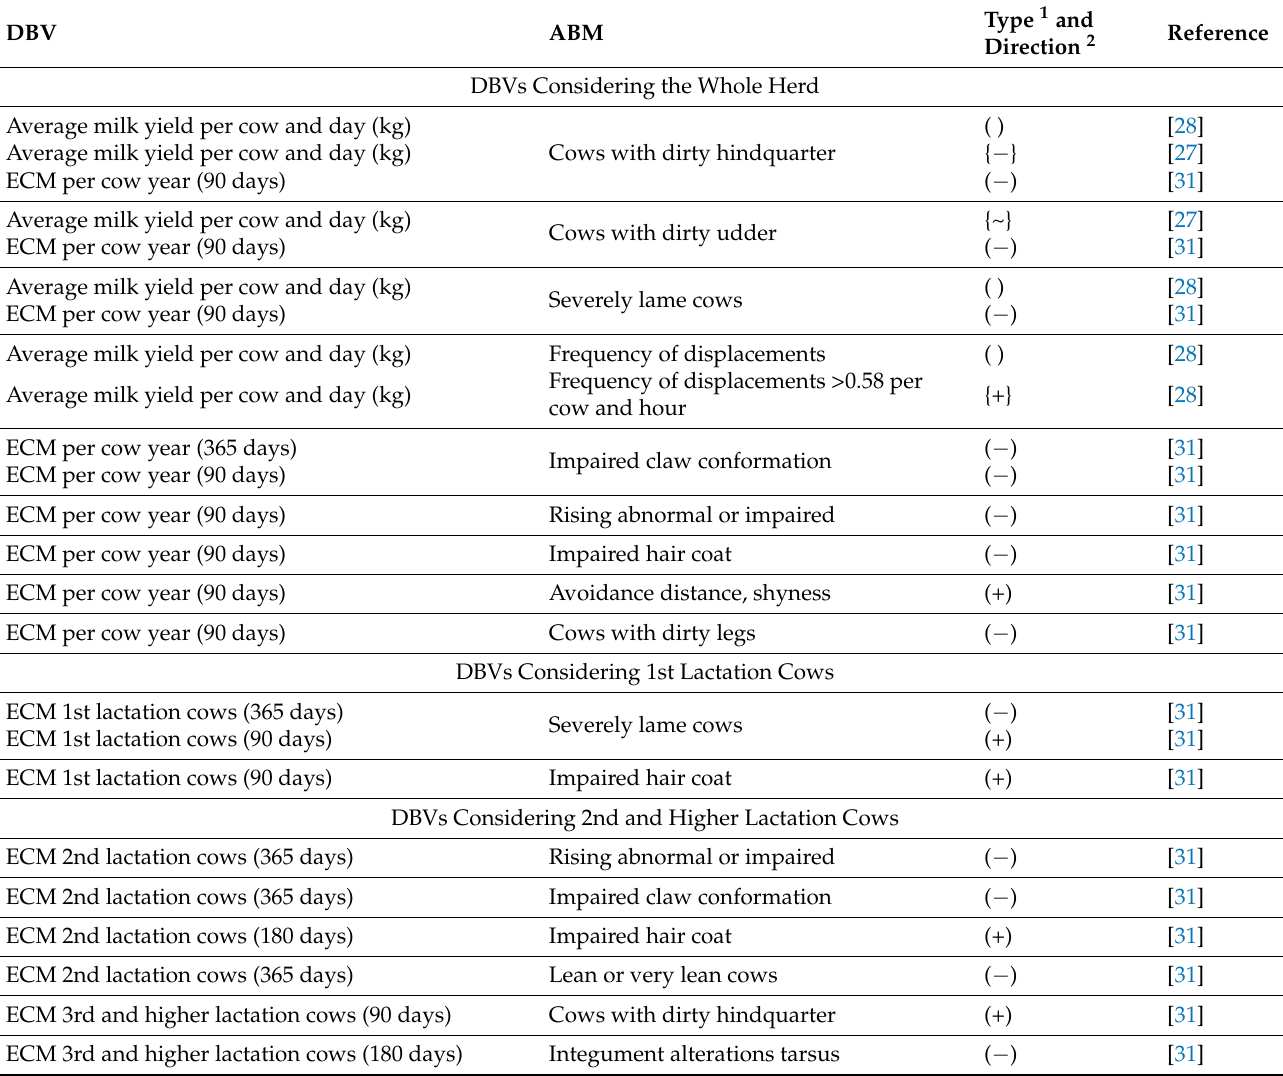
Type 1 and Reference Direction 2